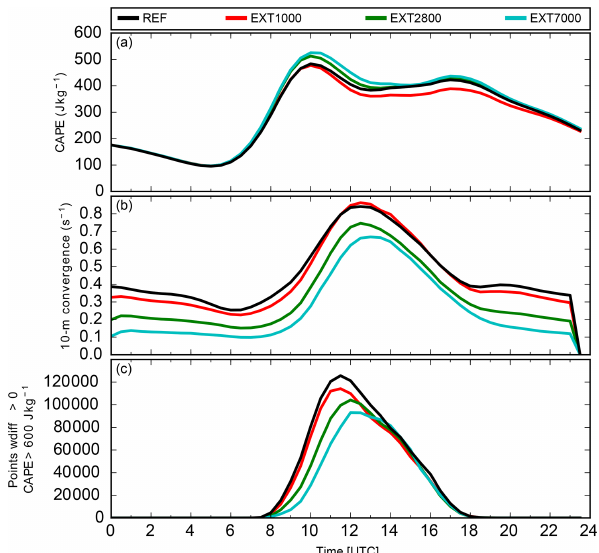
Figure 9. Temporal evolution of CAPE, 10m wind convergence, and number of points with w diff > 0ms − 1 and CAPE>600Jkg − 1 on 30 June 2009 in the orography sensitivity